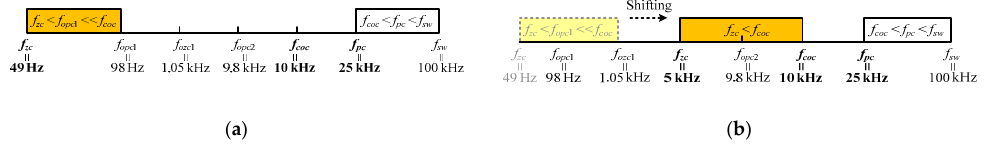
Figure 17. Frequency point design of charge current loop. ( a ) Normal PI design. ( b ) Using the zero break frequency shift (ZBFS) method.